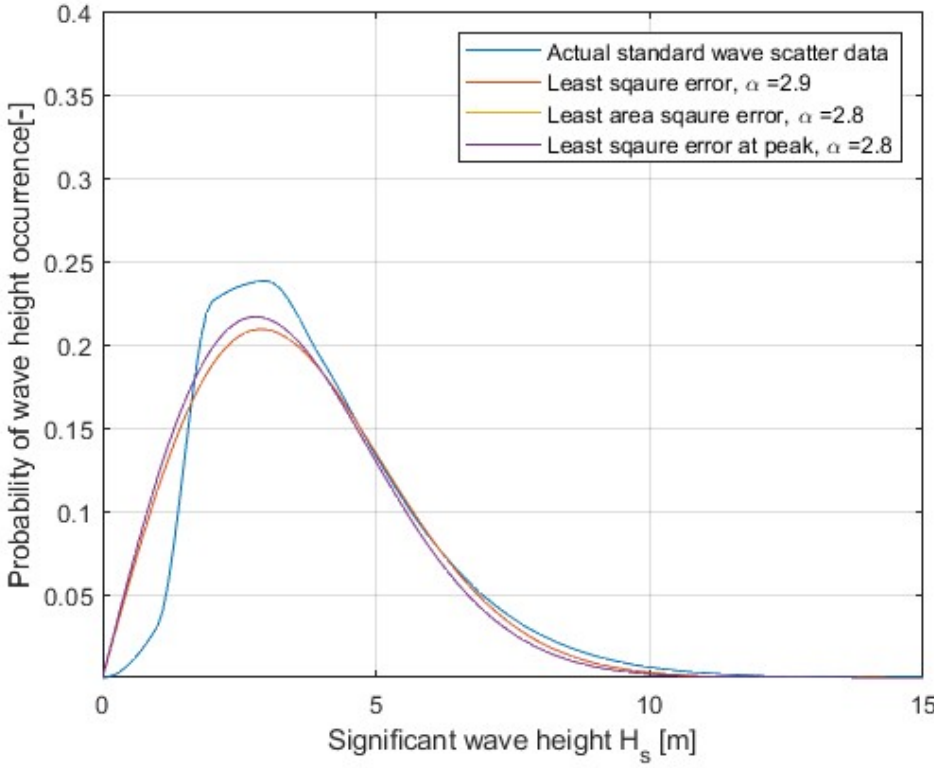
Figure 6. Hindcast WST for swell sea (sea area S—full year).